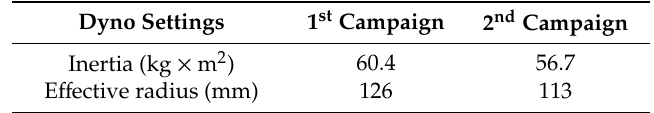
Table 2. Dynamometer settings employed in the two measurement